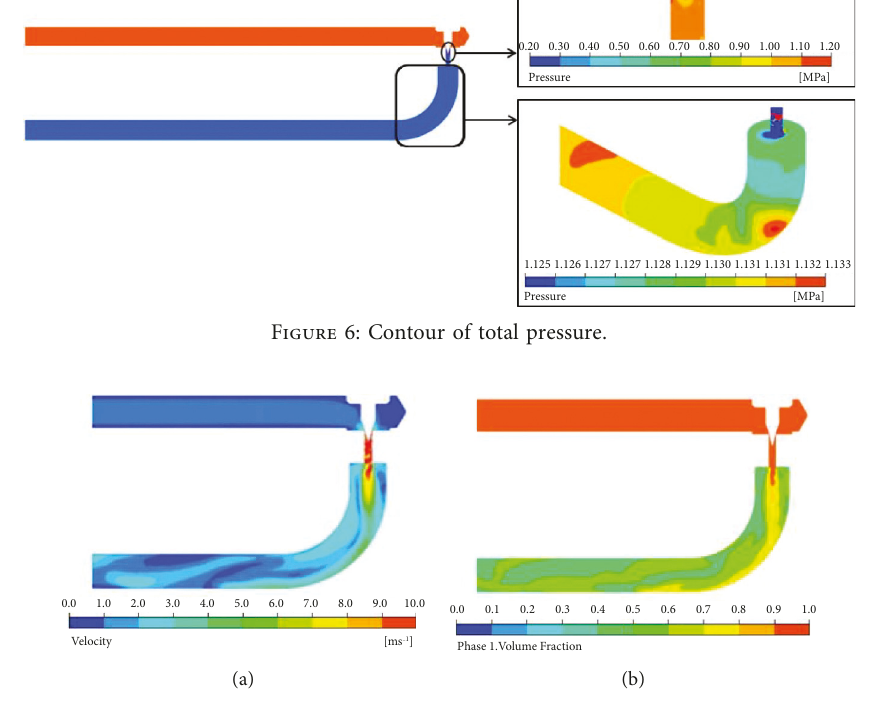
Figure 7: Contour of velocity (a) and liquid phase fraction (b).